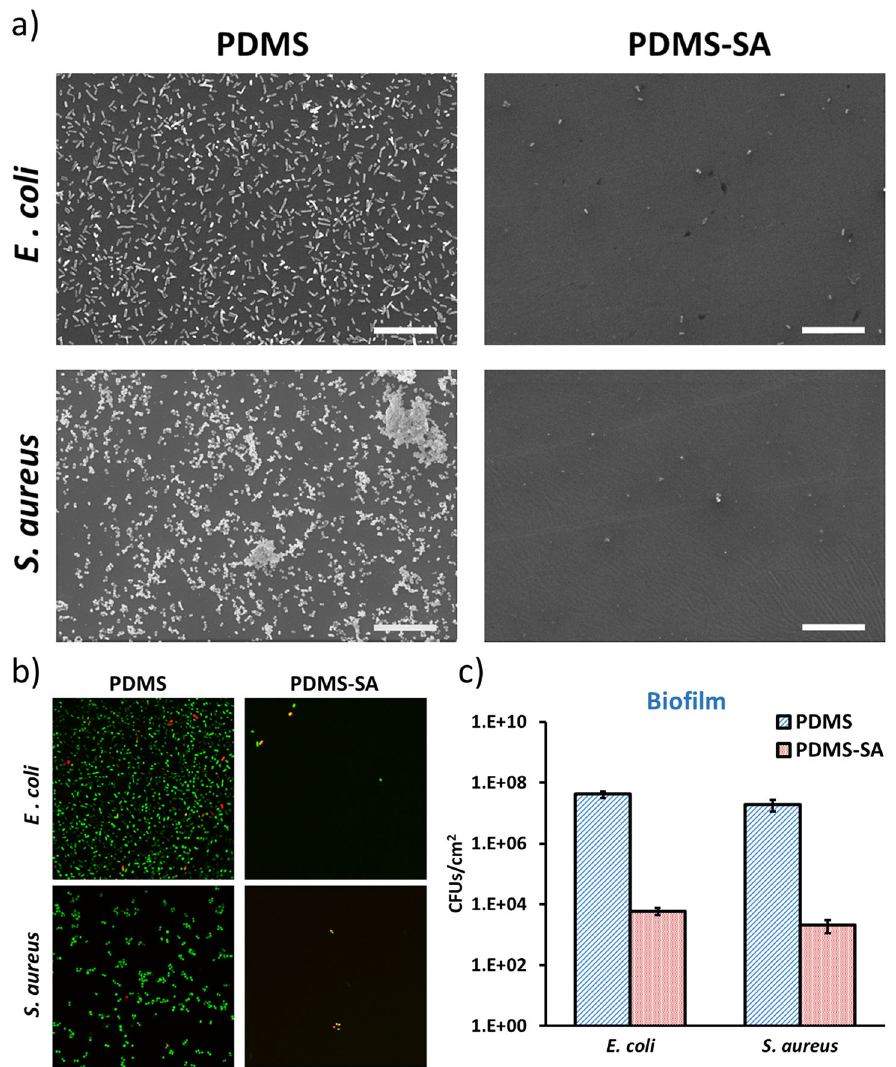
Fig. 8 Antimicrobial activity of PDMS-SA samples against sessile E. coli and S. aureus cells compared to PDMS control samples. a Representative scanning electron microscopy images of E. coli and S. aureus at the surface of PDMS and PDMS-SA samples after 24 h of incubation (scale bar 20 µm); b Representative confocal fl uorescence images of bacteria at the surface of PDMS and PDMS-SA samples after 24 h, as stained by Live/Dead fl uorescent labelling, showing live cells in green and dead cells in red/yellow (image size 71 µm × 71 µm); c Inhibition of sessile E. coli and S. aureus cells after 24 h of incubation (inoculum 10 4 CFU/ml) on